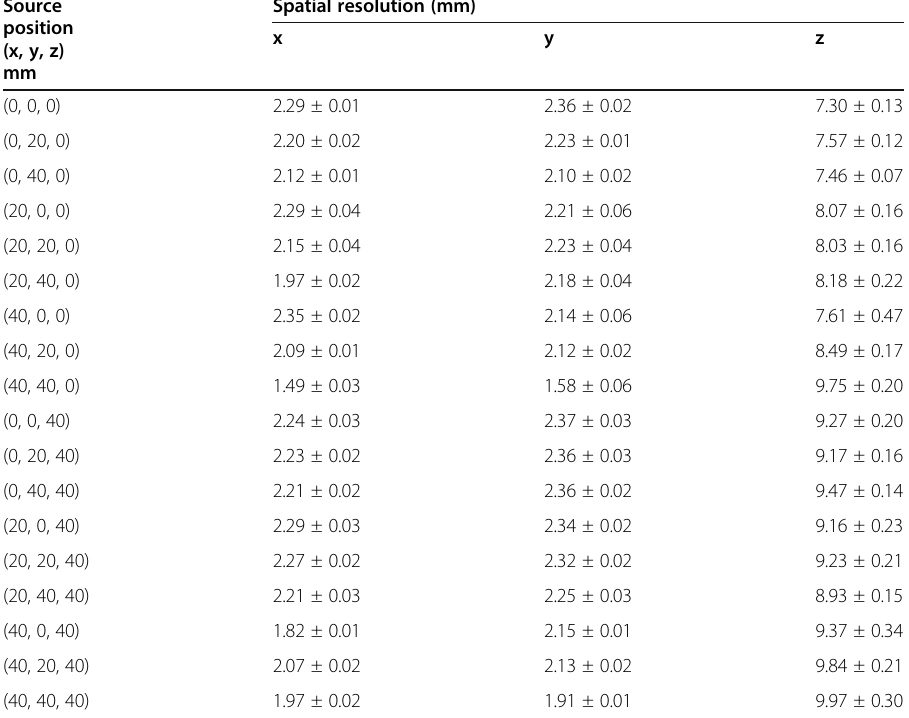
Table 2 Point source spatial resolution at different positions Source position